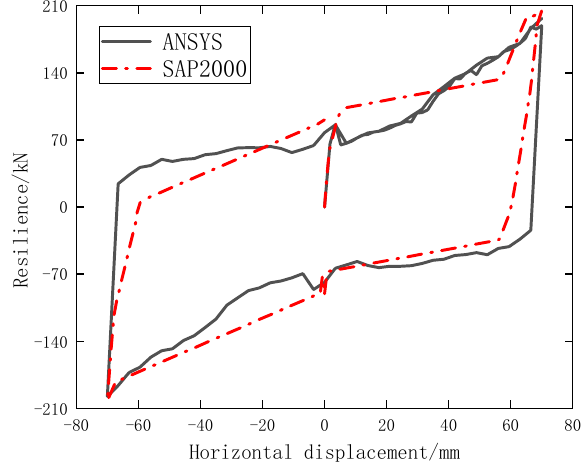
Figure 20. Restoring force-displacement relationship of SMA-negative stiffness isolator.